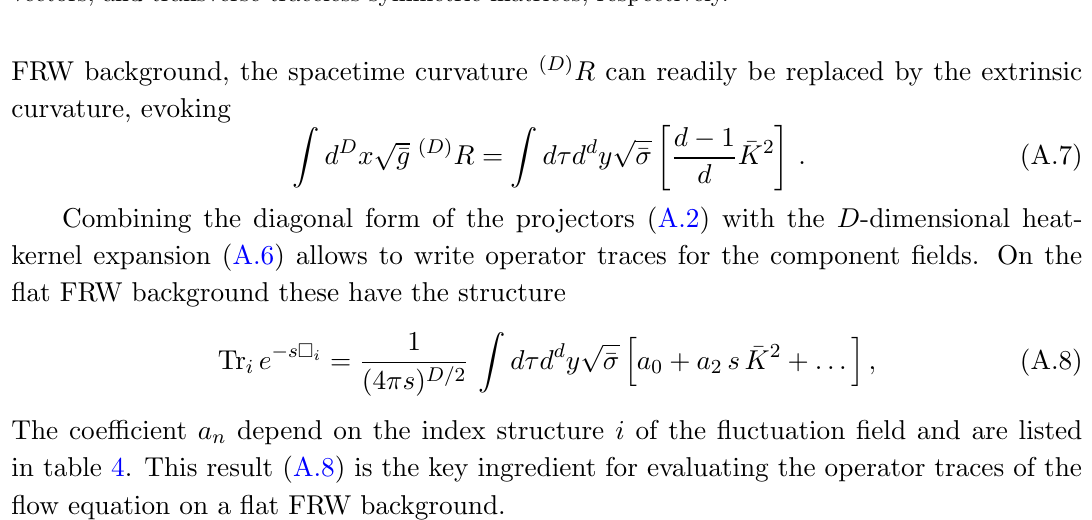
Table 4 . Heat-kernel coe(cid:14)cients for the component (cid:12)elds appearing in the decompositions (3.7) and (3.8). Here S , V , T , TV , and TTT are scalars, vectors, symmetric two-tensors, transverse vectors, and transverse traceless symmetric matrices,